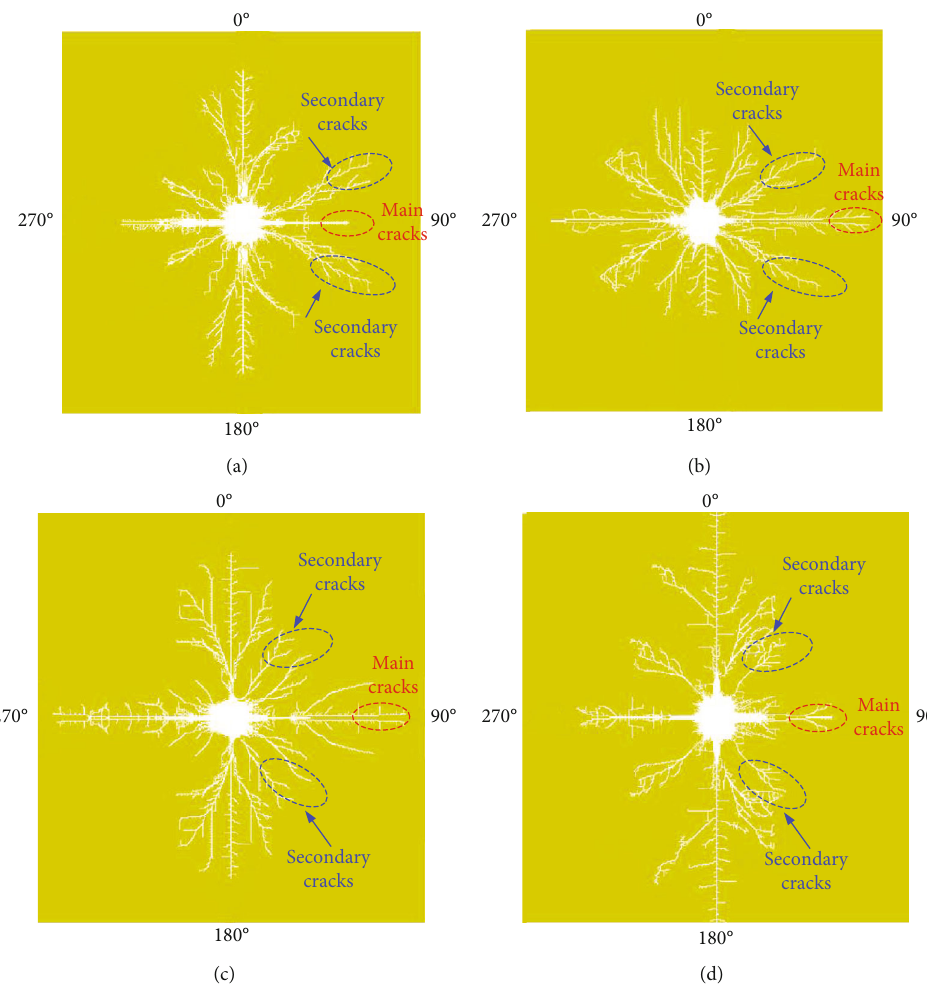
σ σ σ σ σ h = v = 0 MPa; (b) h = 0 MPa, v = 30 MPa; (c) h = 30 MPa, v = 30